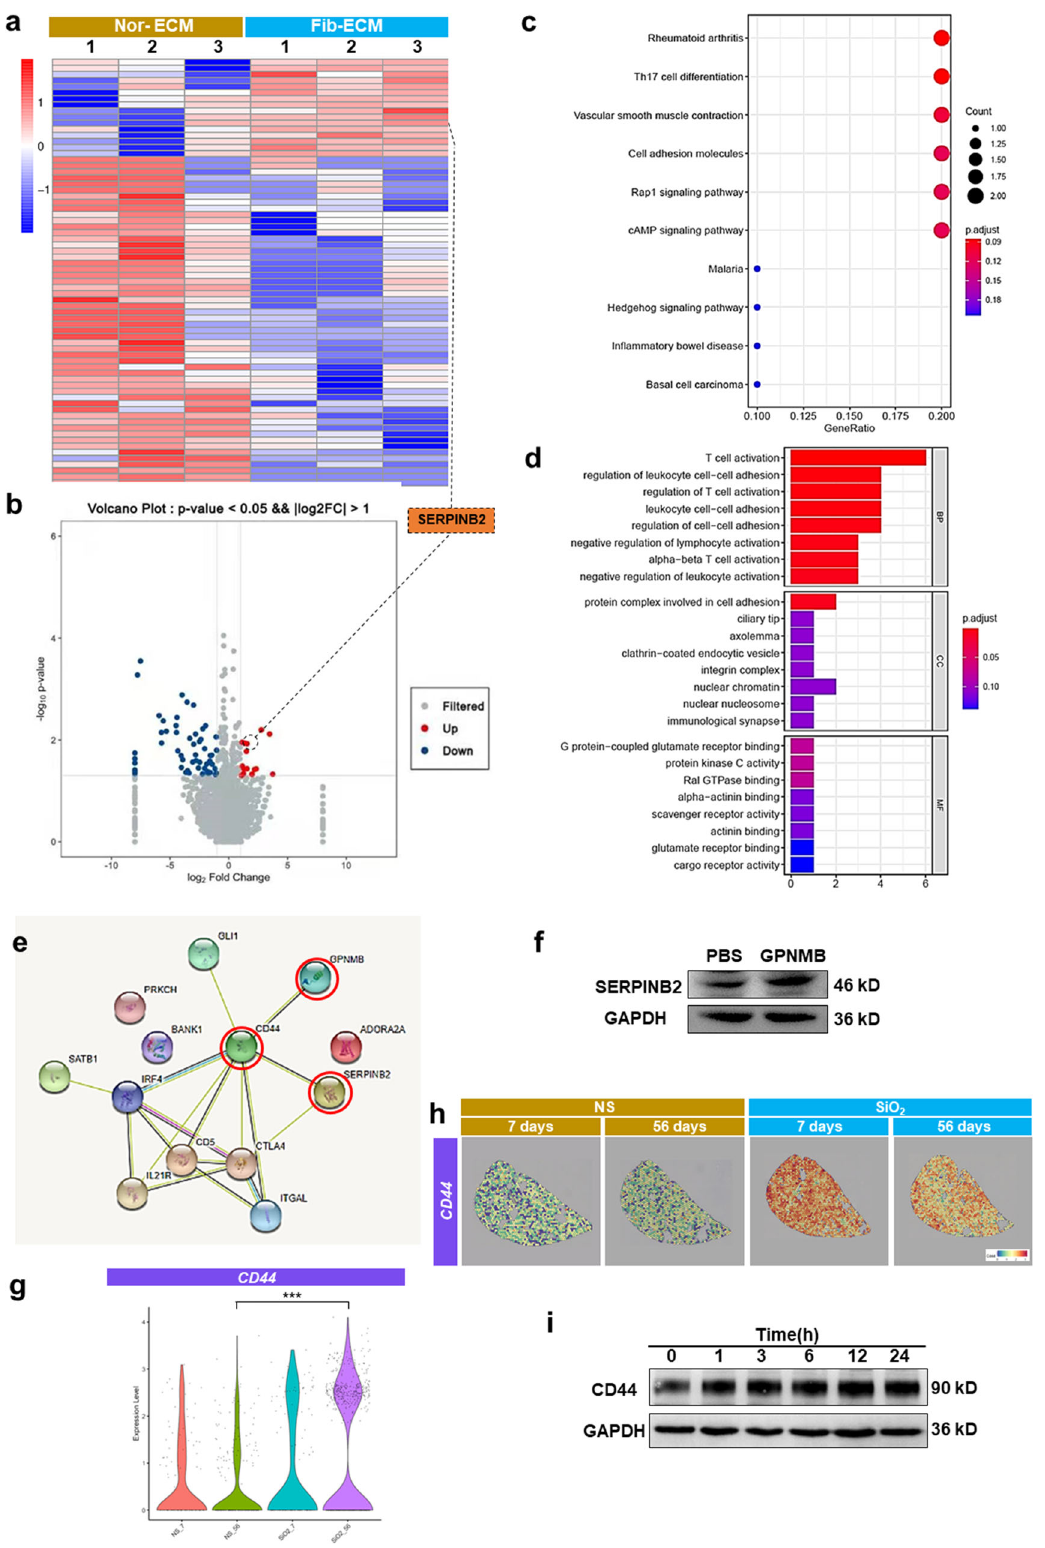
Fig. 7 The CD44/Serpinb2 pathway is related to changes in fi broblast function driven by fi brotic ECM. a Heatmap of differentially expressed mRNAs between fi broblast in different types of ECM. b Volcano plot of differentially expressed proteins between fi broblasts in different types of ECM; |log2(fc)|>1, p <0.05. c The KEGG pathways analysis of the upregulated mRNAs. d The GO enrichment analysis of the upregulated mRNAs. e Protein interaction n e twork analysis between GPNMB and Serpinb2. f The change in Serpinb2 protein levels after GPNMB treatment; n ≥ 5 independent experiments. g The expression level of CD44 gene in different groups on the spatial plots. h The change in CD44 levels in the four groups, as determined by spatial transcriptomics. i CD44 protein levels i n fi broblasts after TGF β 1 (5ng/mL) treatment; n ≥ 5 independent experiments. NS, normal saline; Nor-ECM, normal ECM; Fib- ECM, fi brotic